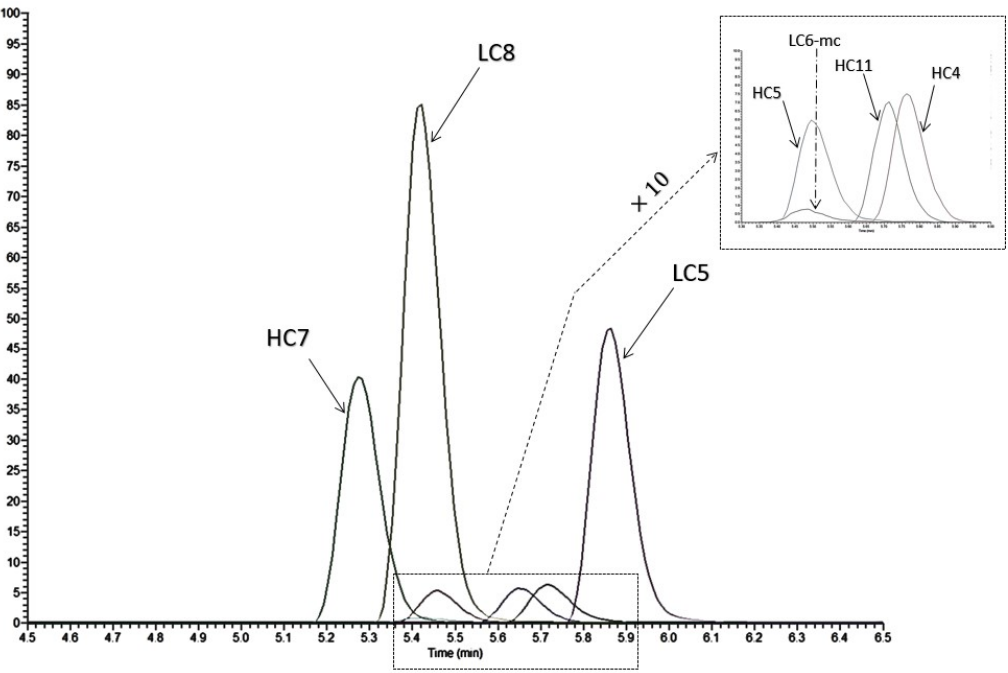
Figure 2. Amino-acid sequences of the heavy chain (HC) and the light chain (LC) of pembrolizumab (PBZ). In silico data indicated that PBZ presented nine tryptic proteotypic peptides. Among them, only two peptides, DLPLTFGGGTK (LC8) and ASGYTFTNYYMYWVR (HC5), were also present in SIL-PBZ-like and were detectable in Full Scan mode in plasma (Figure 3).